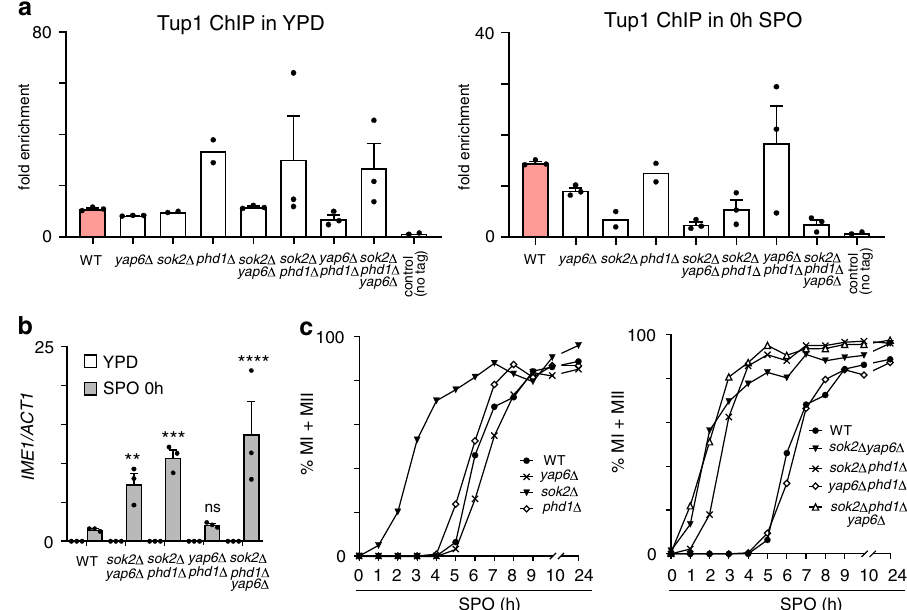
Fig. 7 Yap6, Sok2 and Phd1 direct IME1 repression to control meiotic entry. a Tup1 binding at the IME1 promoter in nutrient rich conditions (YPD) and prior to entry into meiosis (0 h in SPO) in wild-type cells (FW3456) or cells harbouring sok2 Δ , phd1 Δ and yap6 Δ single deletions (FW3979, FW3991, FW3603); sok2 Δ phd1 Δ , yap6 Δ phd1 Δ and sok2 Δ yap6 Δ double deletions (FW4710, FW4406, FW4239); and sok2 Δ phd1 Δ yap6 Δ triple deletions (FW4010). An untagged control (FW1511) was also included in the analyses. The mean and SEM values of n = 3 is displayed, except for sok2 Δ , phd1 Δ and the untagged control for which the mean of n = 2 is displayed. b IME1 expression in deletion mutants described in ( a ). The signals were normalised over the ACT1 gene signals. Mean and SEM values of n = 3 are displayed. Two-way ANOVA analysis was carried out using the uncorrected Fisher ’ s LSD method with 95% con fi dence to compare IME1 expression in mutant cells against wild-type control cells at SPO 0 h. Non-signi fi cant (ns) and p values (** = ≤ 0.01, *** = ≤ 0.001, **** = ≤ 0.0001) are indicated. c Meiosis in mutant strains described in ( a ). Samples were taken at the indicated time points, fi xed and DAPI masses were counted ( n = 200 – 300 cells per sample) to determine the percentage of cells that underwent meiosis (MI + MII). Cells harbouring two, three or four DAPI masses were classi fi ed as